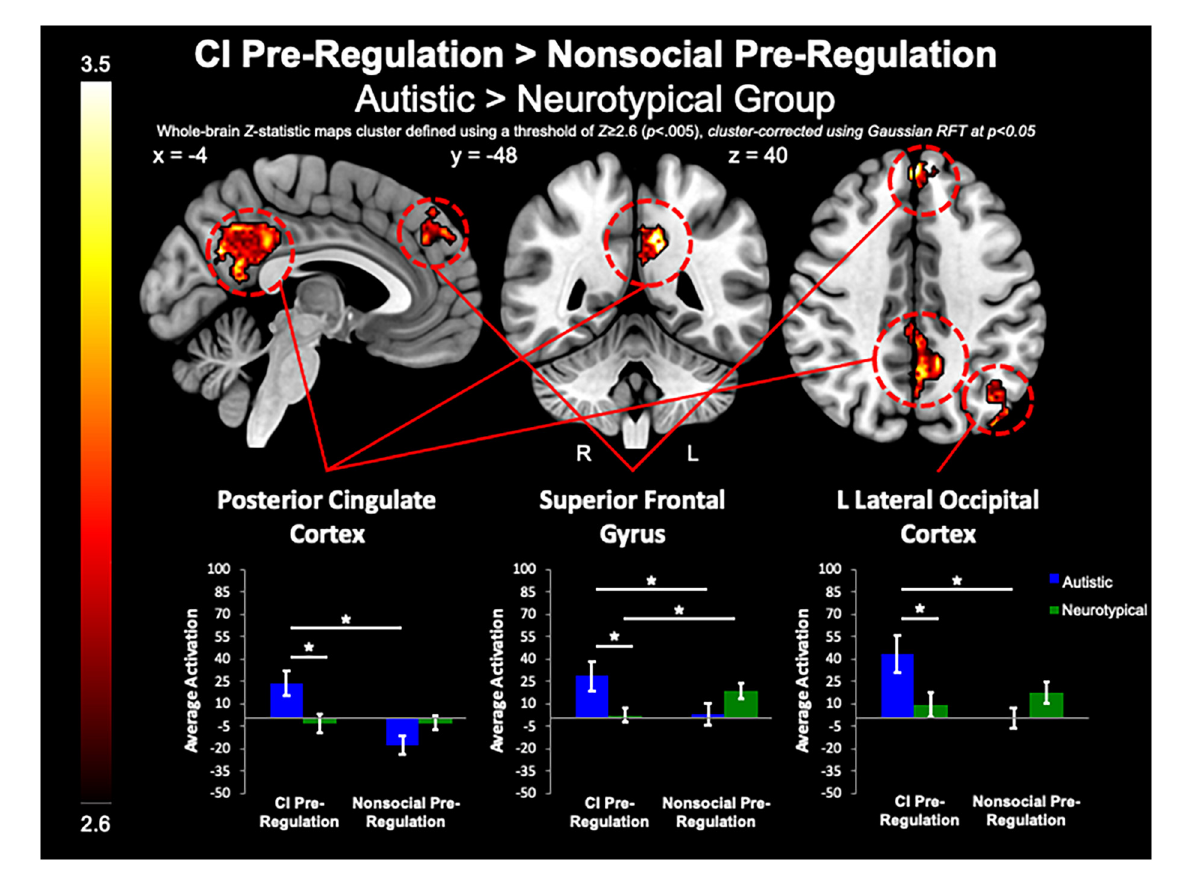
FIGURE5 CI pre-regulation > nonsocial pre-regulation. Compared to controls, the autistic group demonstrated increased activation in the PCC and SFG, and L Lateral Occipital Cortex when viewing CI images vs. viewing nonsocial object